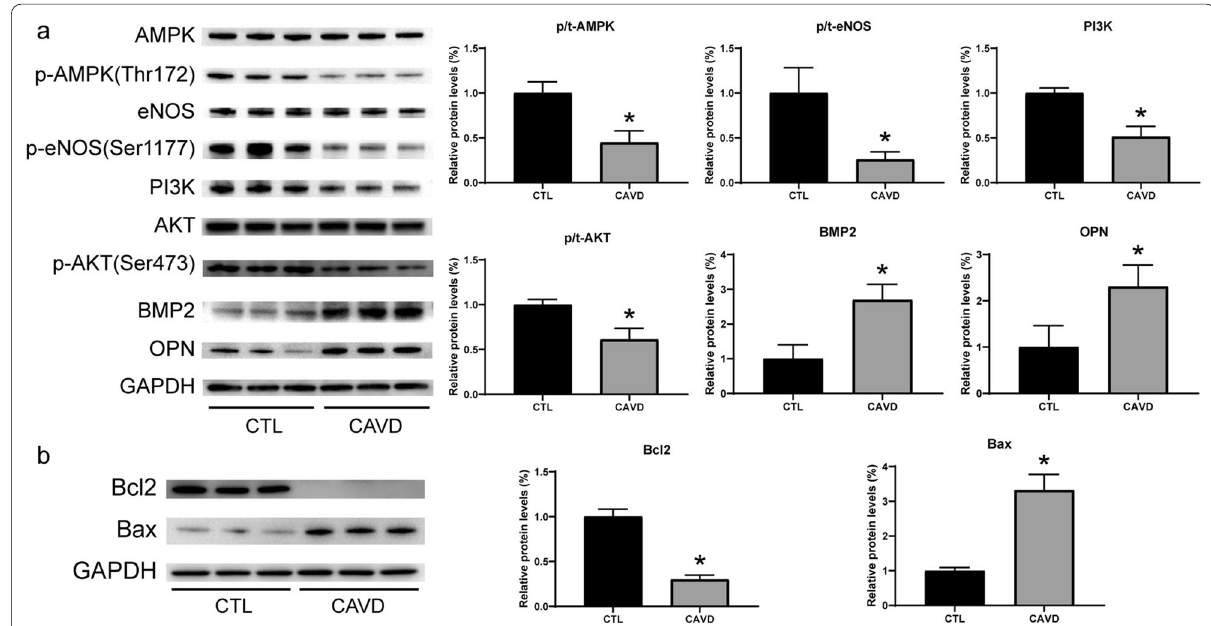
Fig. 3 Protein expression level change between control and calcific aortic valves. a Protein expression levels of p-AMPK (Thr172), p-AKT (Ser473), PI3K, p-eNOS (Ser1177), BMP2, and OPN of control (n 9) and calcific (n 8) valves were determined by WB and quantification analysis; b protein = = expression levels of Bax and Bcl2 were determined by WB and quantification analysis. CTL control; CAVD calcific aortic valve disease; *p < 0.05 versus control group (Student’s